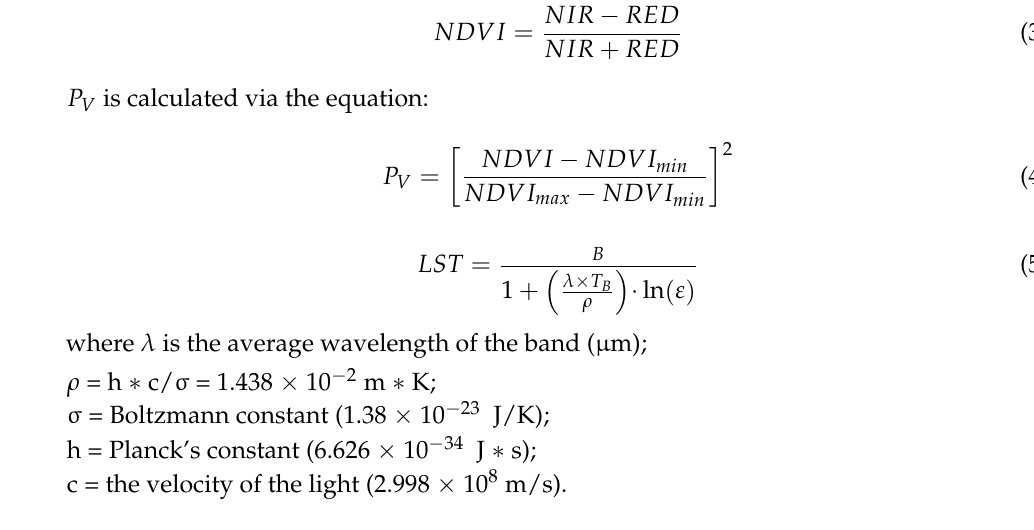
Table 2. NDVI threshold model used in this study